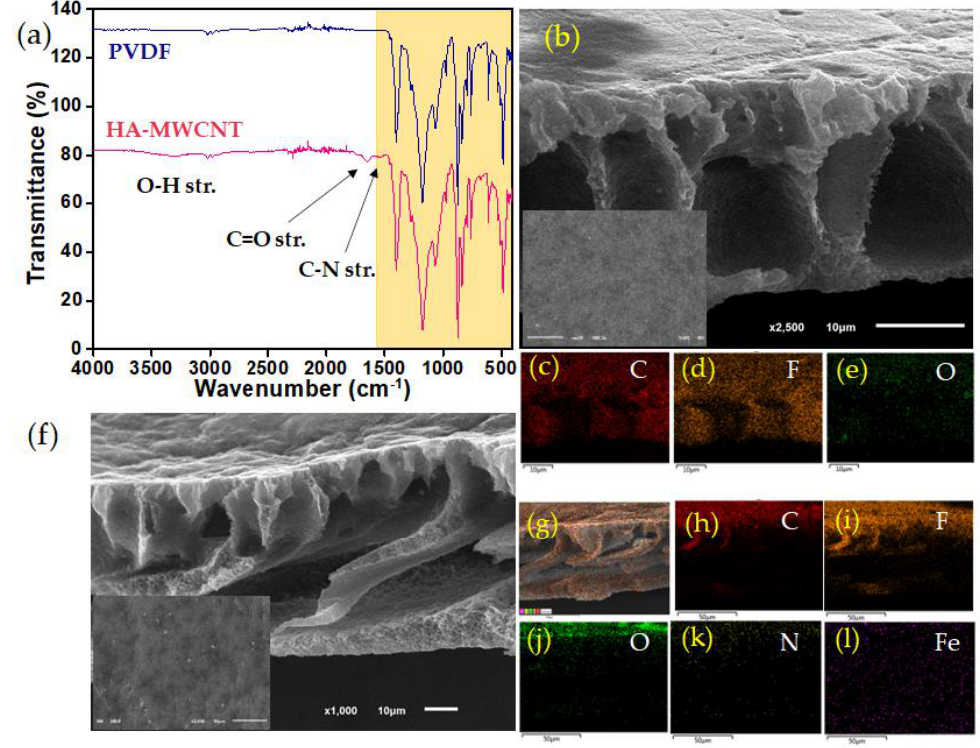
Figure 5. ( a ) The FTIR spectra of the PVDF and the HA-MWCNT membranes, ( b ) the FESEM of the PVDF membrane with the elemental mapping on the cross-section shown in ( c – e ). The morphology of the HA-MWCNT membrane is shown in ( f ), while the elemental mappings are shown in ( g – l ). The surface morphologies of both membranes are shown as insets on the cross-sectional views.